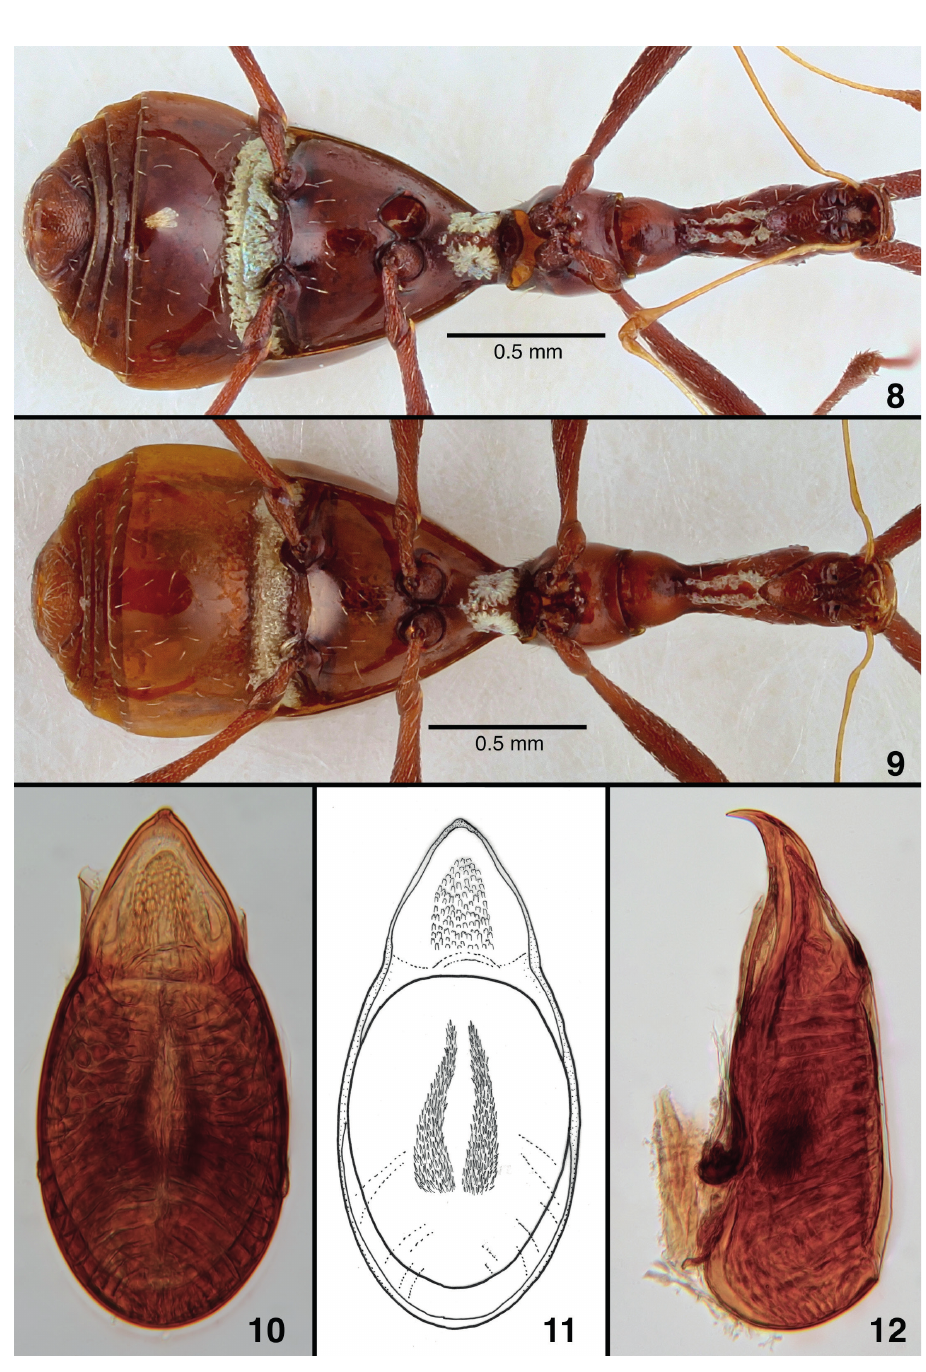
Figures 8–12. Geopselaphus bullonorum Hernando & Castro, sp. nov. Ventral part 8 male 9 female. Aedeagus 10–11 dorsal vision 12 lateral